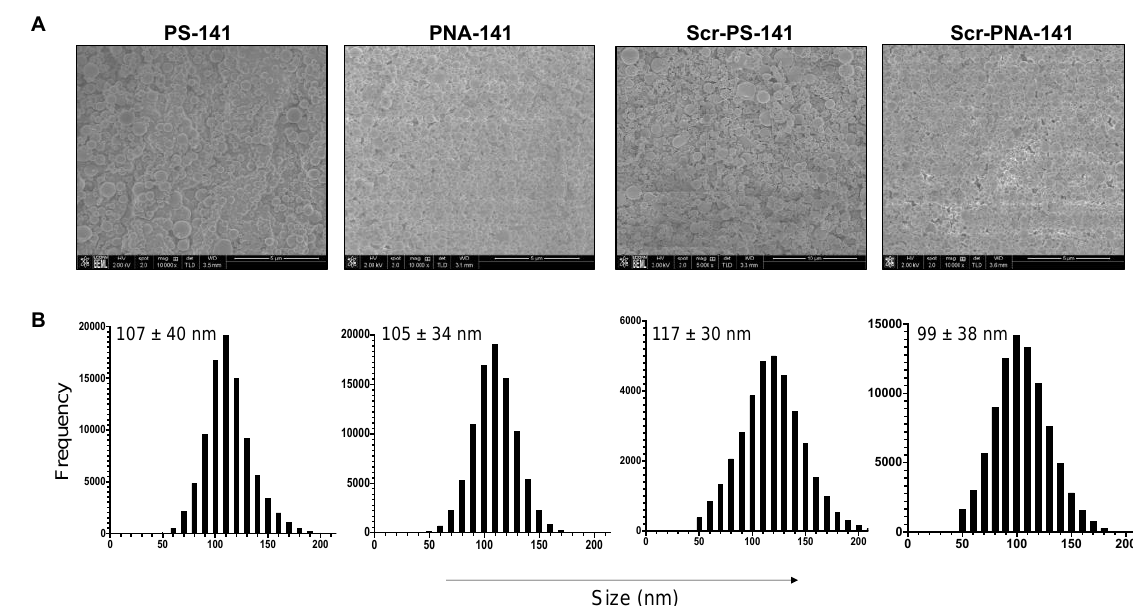
Figure 3. Representative SEM images showing ( A ) morphology and ( B ) size distribution curve of PLGA nanoparticles containing PS-141, PNA-141, Scr-PS-141 and Scr-PNA-141. The average particle diameter (nm) and standard deviation are given for NPs in the size distribution curve. The scale bar is 5 to 10 µm. Table 1. Characterization of PLGA NPs containing antimiR-141 sequences. Mean diameter and polydispersity index (PDI) was calculated using dynamic light scattering (DLS), and the surface charge was calculated using zeta potential.